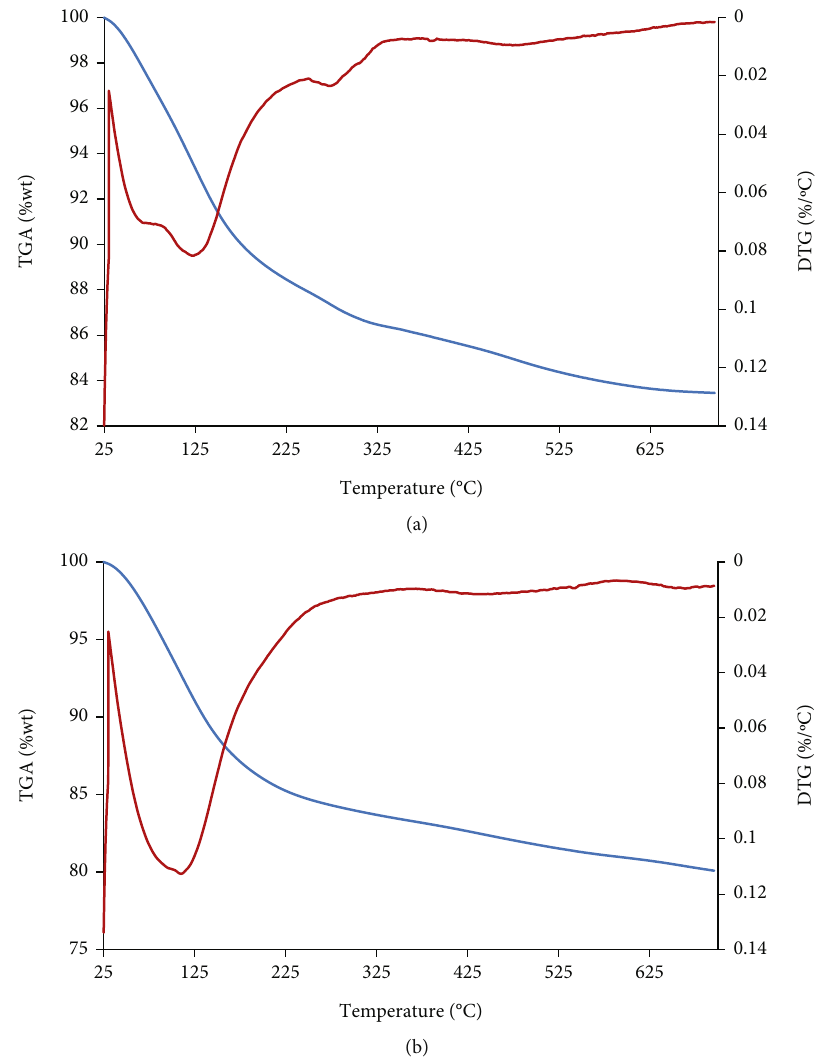
Figure 4: Results of TGA and DTG for the zeolite samples: (a) CH-N and (b) CH-MS. Table 2: Chemical composition of the chabazite and its modi fi ed